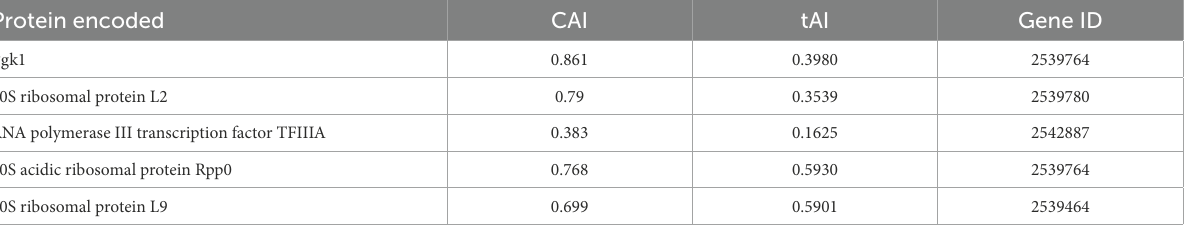
TABLE 1 Codon adaptation index (CAI) and tRNA adaptation index (tAI) of Schizosaccharomyces pombe genes. Protein